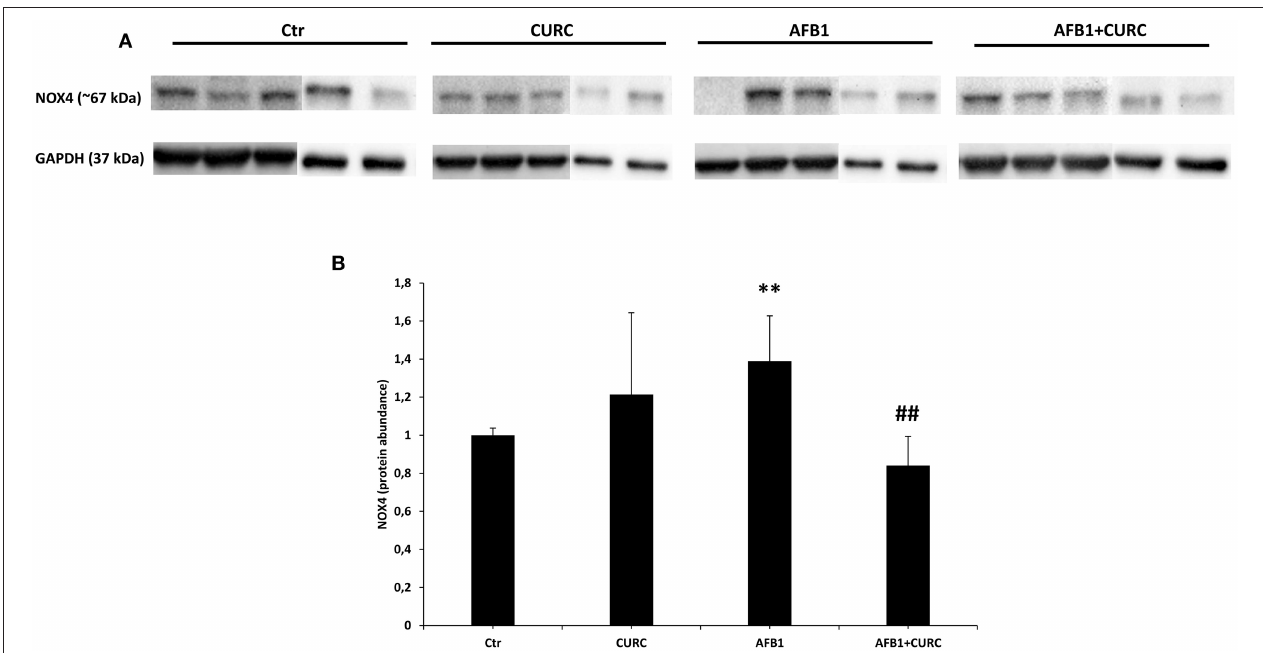
FIGURE 6 | NOX4 protein expression in the kidney of broilers at the end of treatment (T10). (A) Representative western blot of NOX4. (B) Densitometric analysis of NOX4. Values were normalized toward GAPDH. Densitometric analysis is ex-pressed as arbitrary units. Ctr, control group; CURC, Curcumin group; AFB1, Aflatoxin B1 group; AFB1 + CURC, Aflatoxin B1 group plus Curcumin. Data are expressed as mean ± standard deviation (SD), n = 8 (** p < 0.01 vs. Ctr; ## p < 0.01 vs. AFB 1).